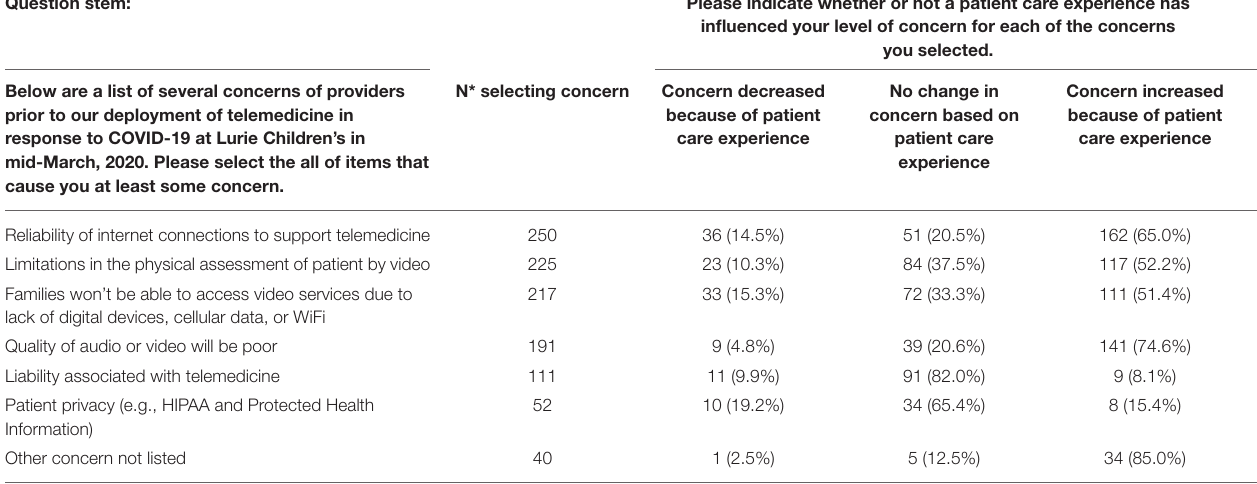
TABLE 3 | Impact of patient care experience on telemedicine concerns. Question stem: